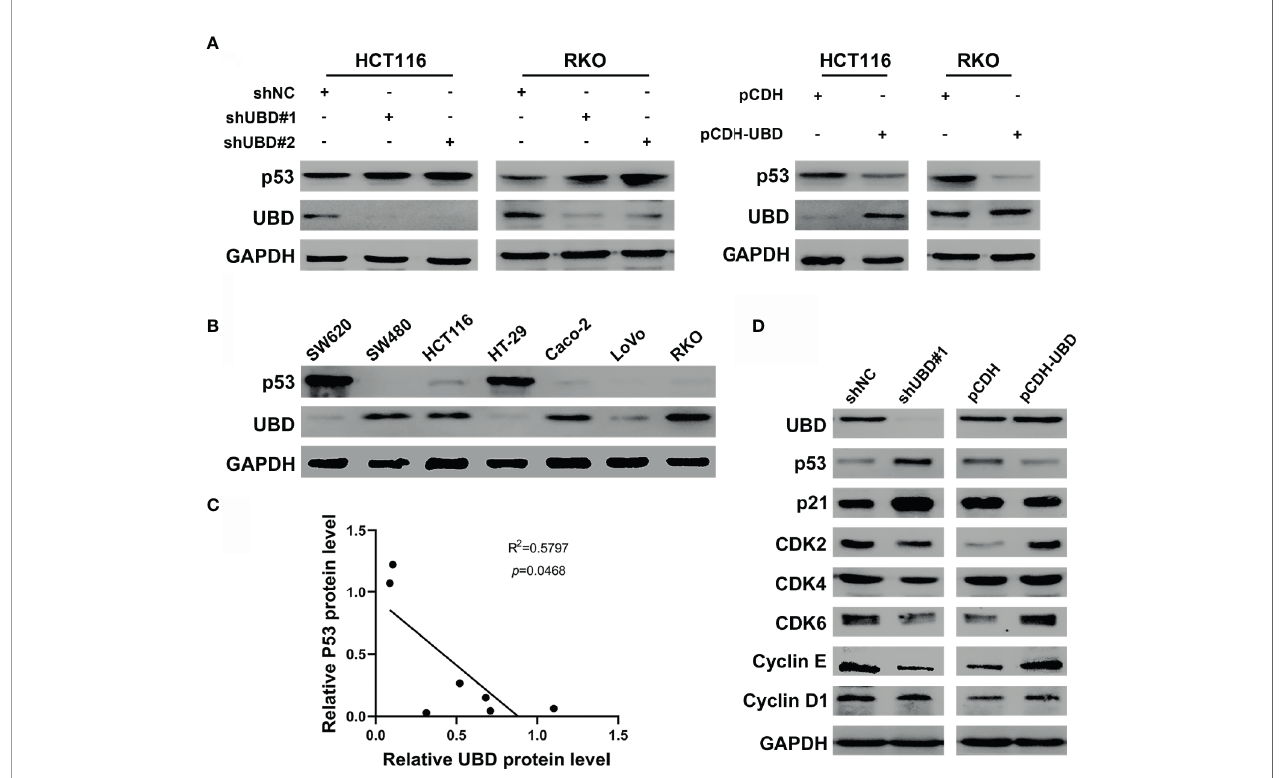
FIGURE 4 | UBD negatively regulates the expression levels of p53 in CRC. (A) The protein expression level of p53 in HCT116 and RKO cells transfected with stable knockdown or overexpression plasmid. (B) Expression level of UBD and p53 protein were detected in seven CRC cell lines. (C) Pearson correlation analyzed the correlation between UBD and p53 protein expression level in CRC cells (R 2 = 0.5797; p = 0.0468). (D) Western blotting was used to detected the protein expression of downstream genes of p53 pathway in HCT116 cells transfected with stable knockdown or overexpression plasmid. GAPDH was used as an endogenous control. p53: tumor suppressor